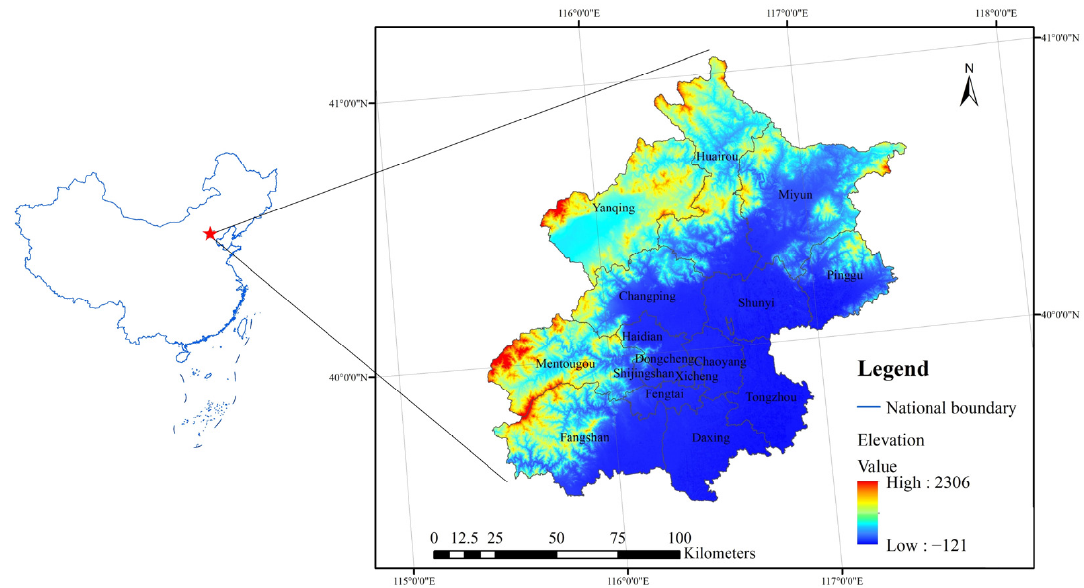
Figure 1. Overview map of the study area.